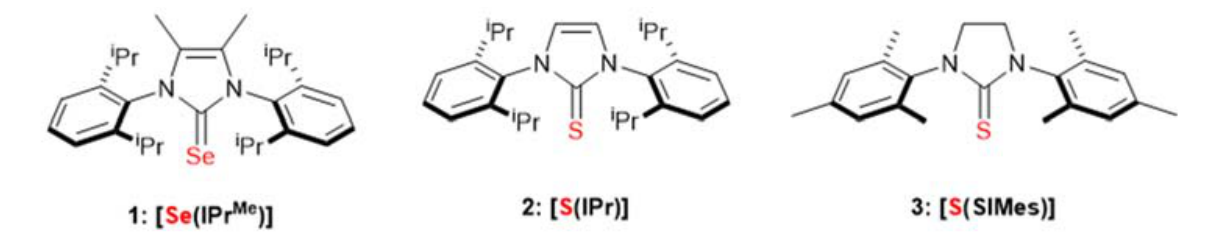
Figure 1. Chemical structures of seleno ‐ and thiourea NHCs used in this